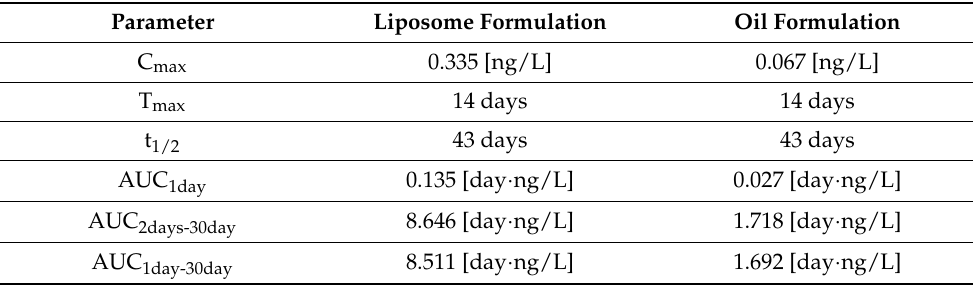
Table 2. Examples of quantitative values of pharmacokinetic parameters determined for a person with significant vitamin D 3 deficiency. Parameter Liposome Formulation Oil Formulation C max 0.335